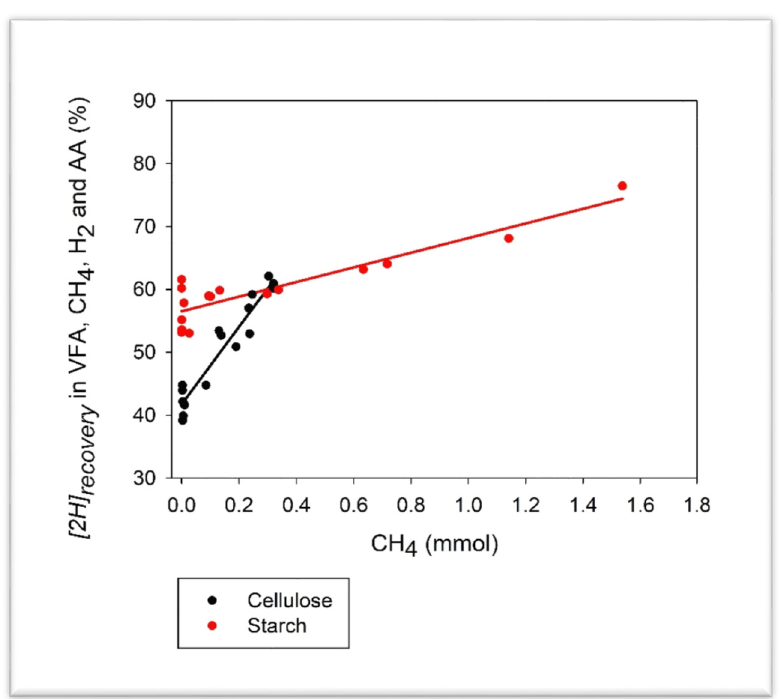
Figure 2. Response in the recovery of metabolic hydrogen in volatile fatty acids (VFA), methane (CH 4 ), dihydrogen (H 2 ), and amino acids (AA) to the inhibition of methanogenesis by 9, 10-anthraquinone in mixed rumen batch cultures growing on cellulose or starch: y = 48.9 ( ± 0.60; p < 0.001) – 1.39 ( ± 0.50; p = 0.009) C + 36.8 ( ± 2.56; p < 0.001) CH 4 + 24.7 ( ± 2.56; p < 0.001) C × (CH 4 – 0.234).